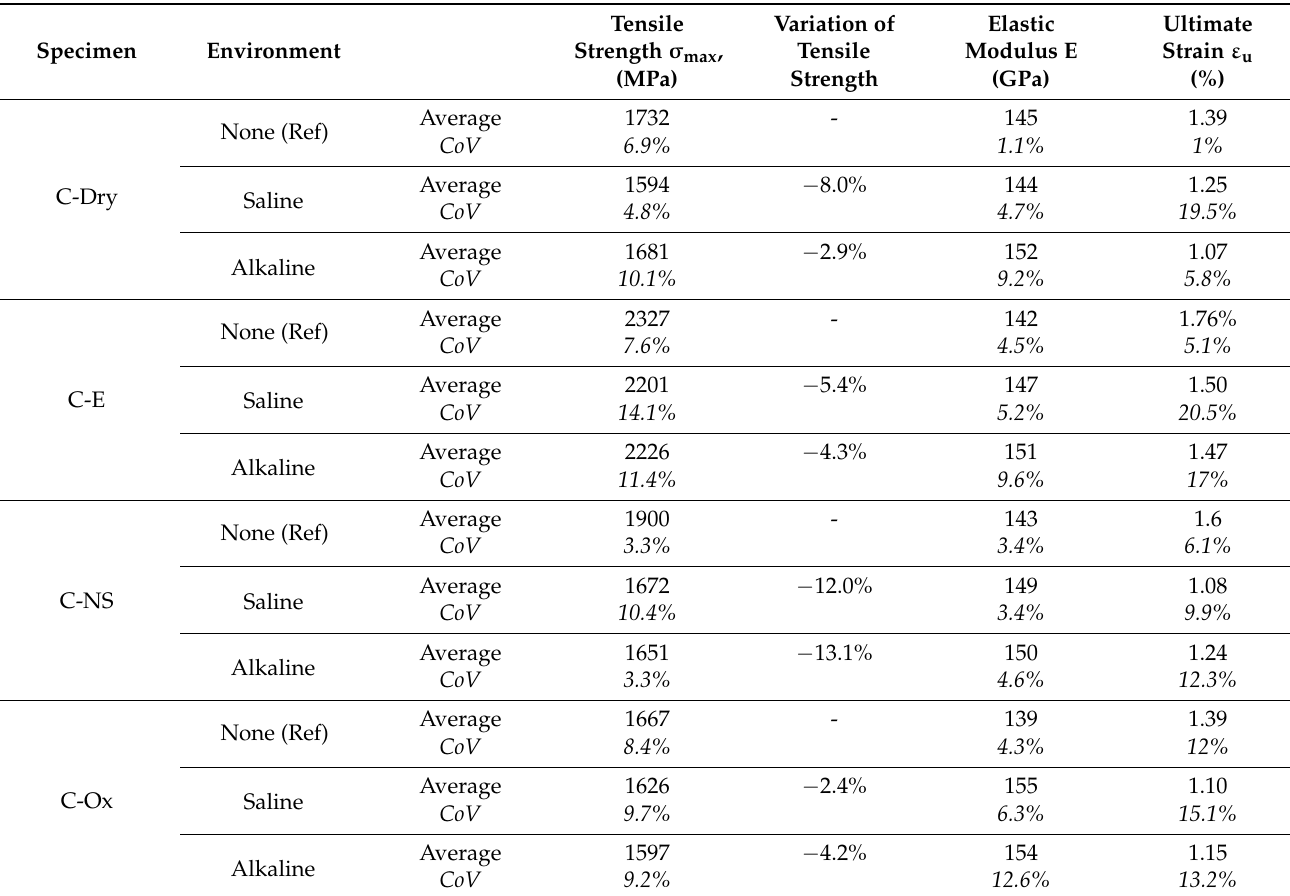
Table 4. Results of tensile tests on carbon